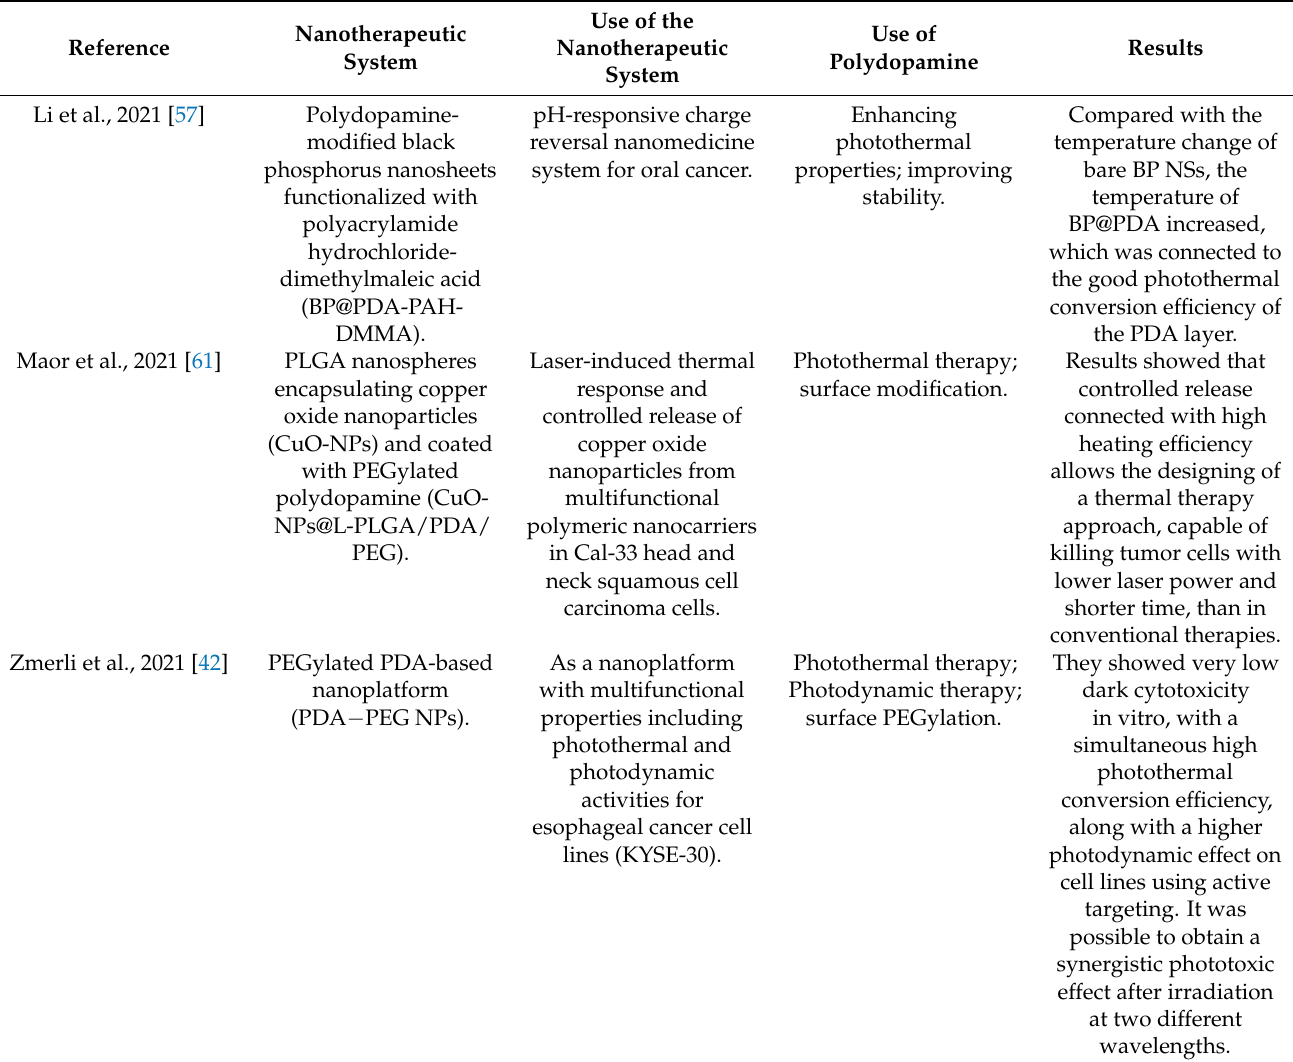
Table 1. Use of polydopamine in the treatment of head and neck